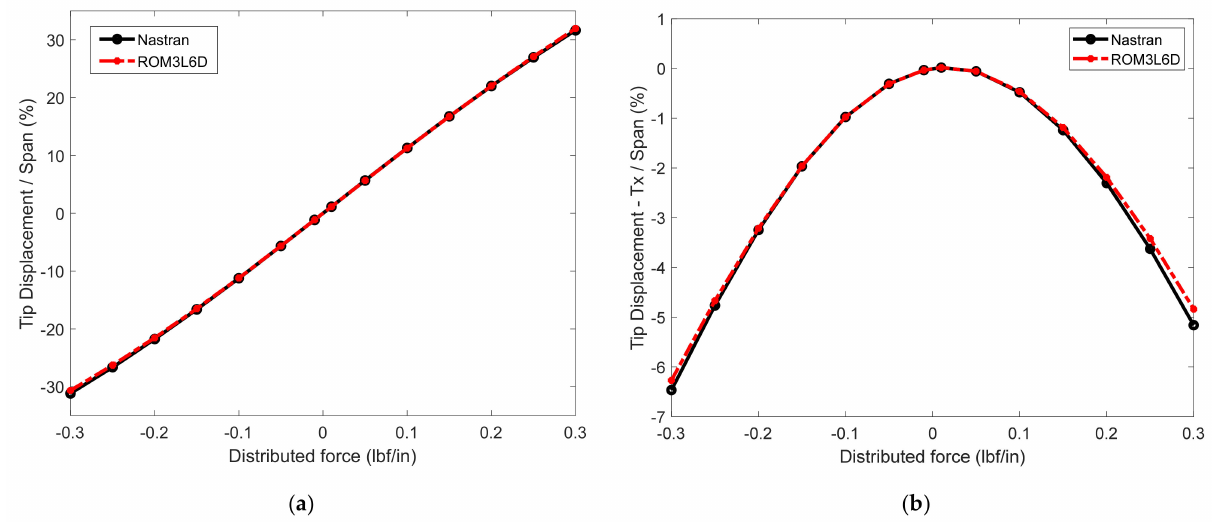
Figure 2. Deflections of the tip of the cantilevered curved beam as a function of the magnitude of a uniformly distributed static load (positive down). Nastran and ROM predictions. ( a ) Transverse, ( b ) in-plane.